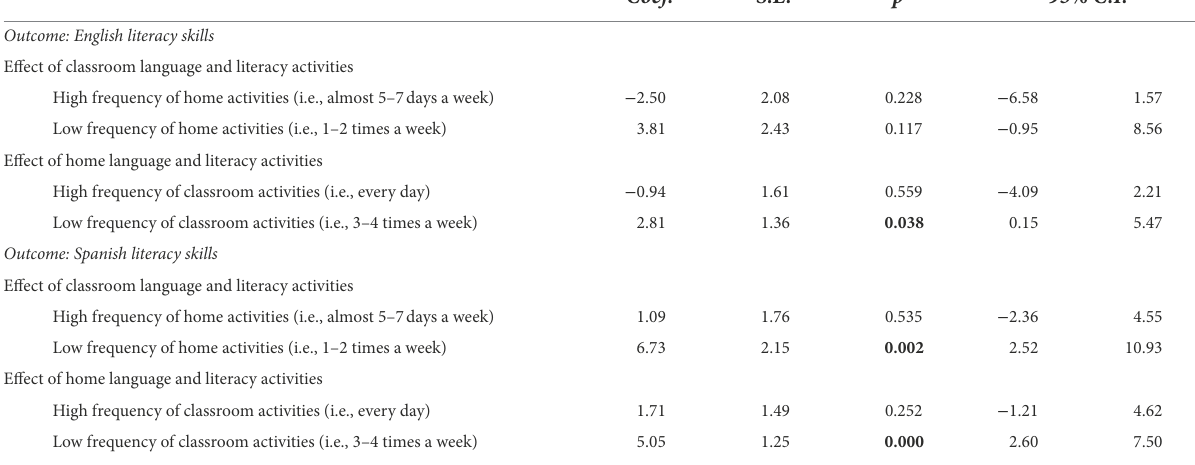
TABLE 3 Conditional effects of home and classroom language and literacy activities on children’s emergent literacy skills in English and Spanish. Coef. 95%